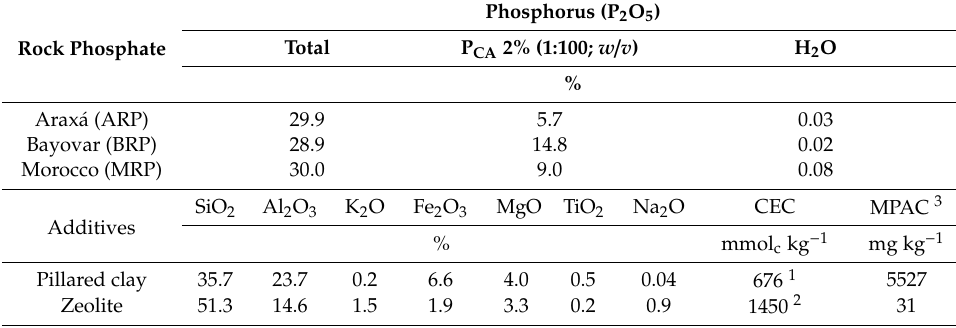
Table 1. Chemical characteristics of the rock phosphates (RPs) used and total chemical composition by X-ray fluorescence, cation exchange capacity (CEC) and maximum P adsorption capacity (MPAC) of pillared clays and